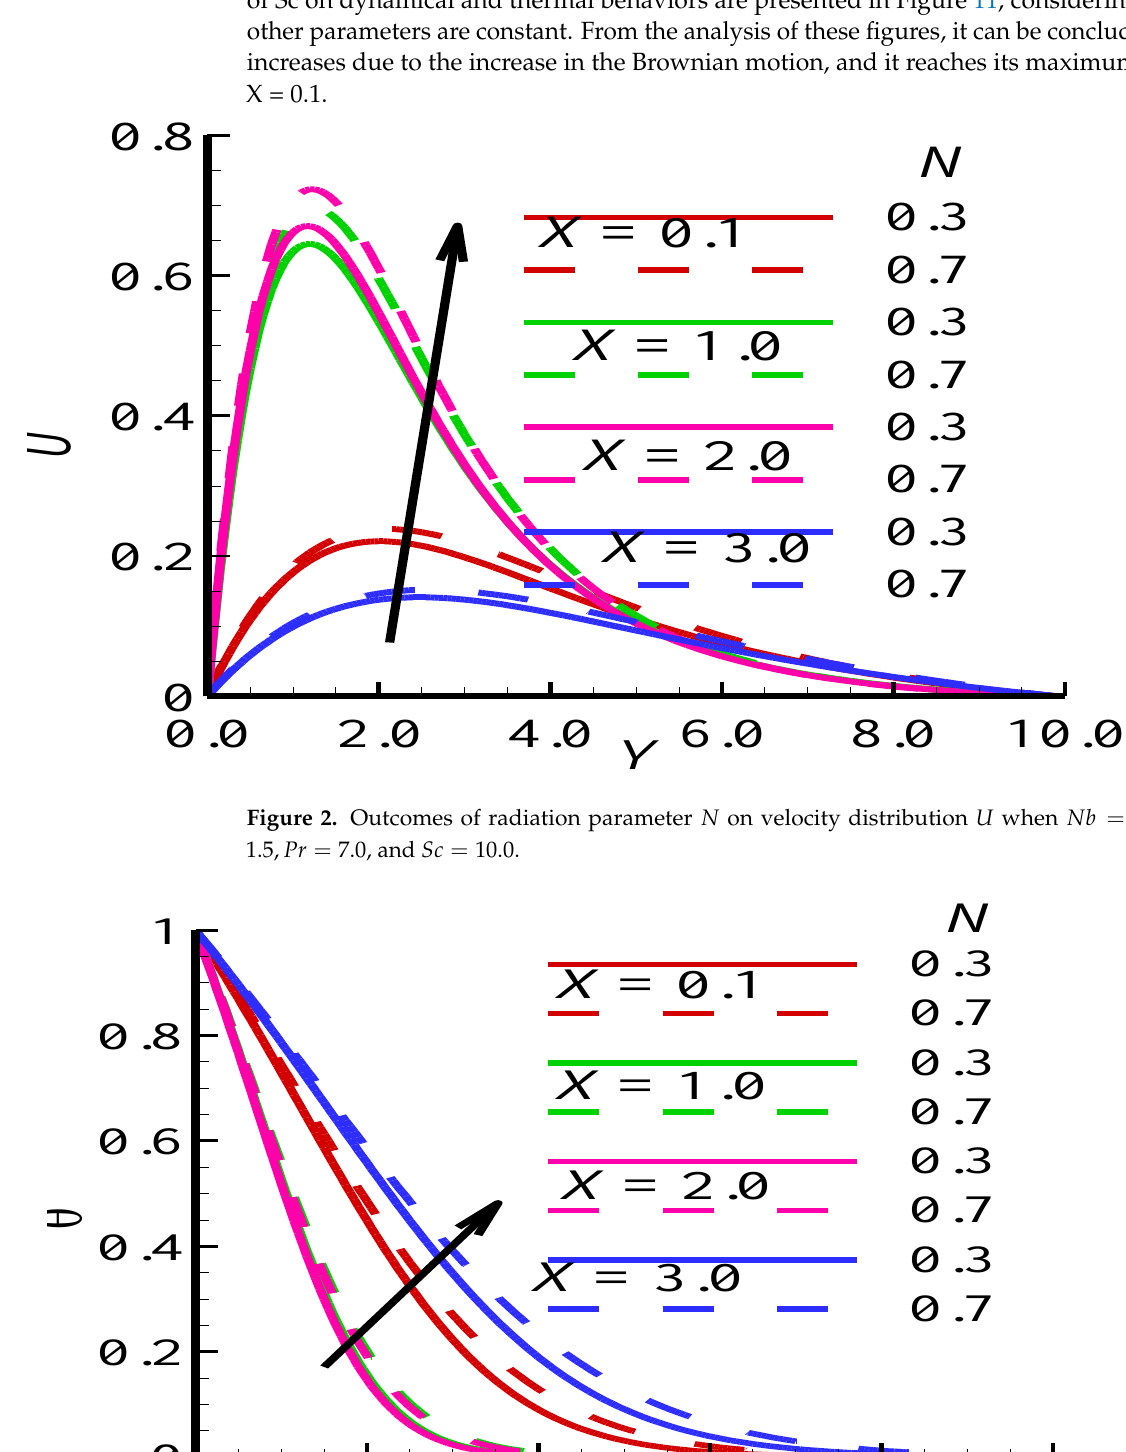
Figure 4. Outcomes of radiation parameter 𝑁 on mass concentration 𝜙 when 𝑁𝑏 = 1.5,𝑁𝑡 = 1.5,𝑃𝑟 = 7.0, and 𝑆𝑐 = 10.0 .